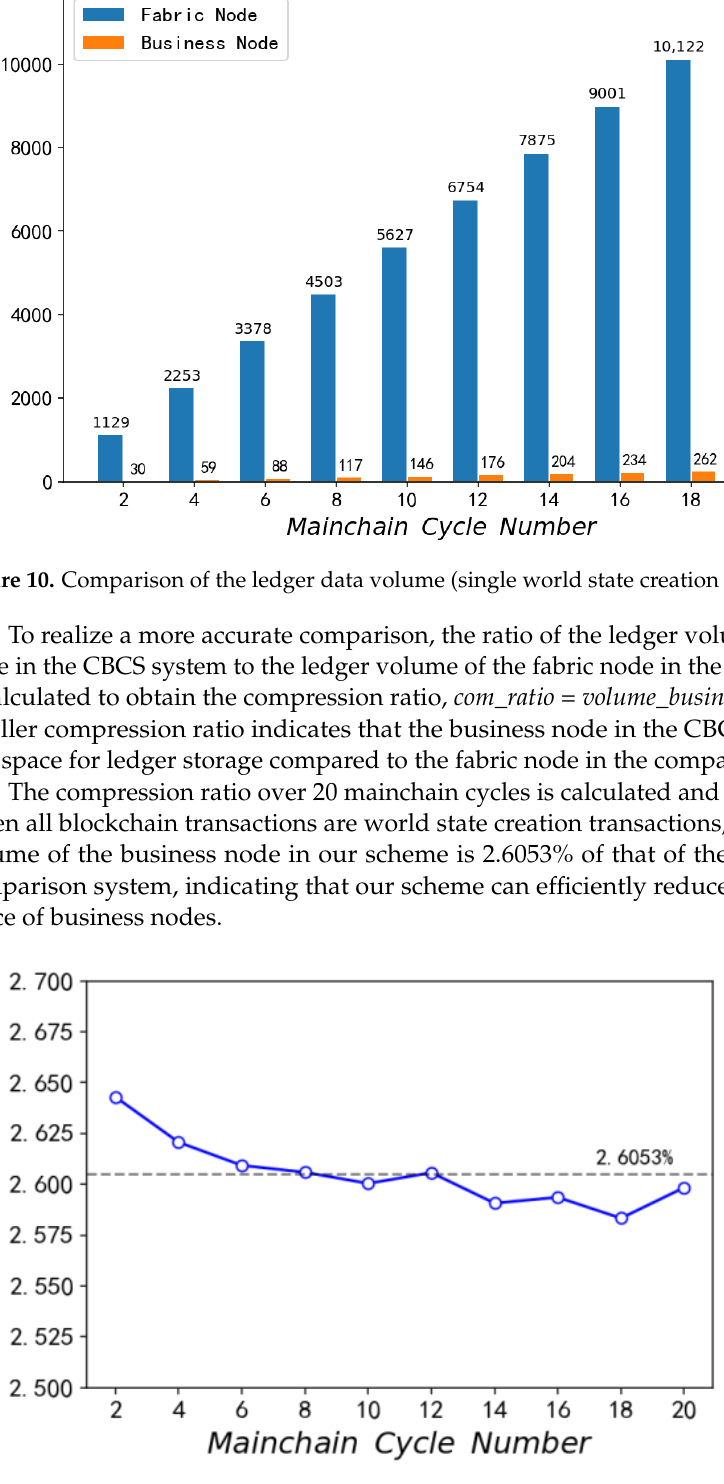
Figure 11. The compression ratio (single world state creation transactions).